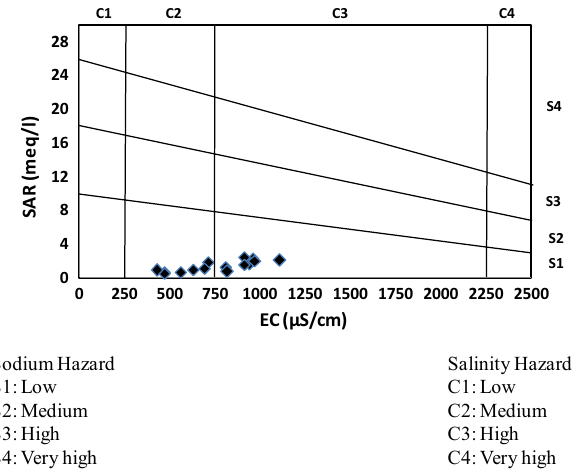
Fig. 8 Groundwater suitability for irrigation based on Doneen perme- ability index plot